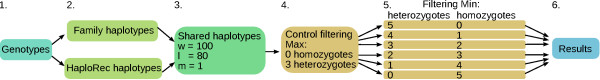
Shared haplotype extraction pipeline. The shared haplotype (SH) extraction workflow comprised six stages. Stage 1: the genotype calls were produced using the Illumina SNP bead arrays and transformed into data matrices. Stage 2: the haplotypes were estimated for the cases with Merlin by using the family information, and for the population controls by using the HaploRec software. Stage 3: all SHs were extracted from cases and controls. Stage 4: SHs were filtered to exclude SHs shared by at least four heterozygous or one homozygous control. Stage 5: pre-filtered SHs were then filtered further in six parallel analyses with thresholds that discover SHs present in at least five lymphoma cases. Stage 6: the ten highest scoring hits more than 30 markers long were combined from each filtering in stage 5.